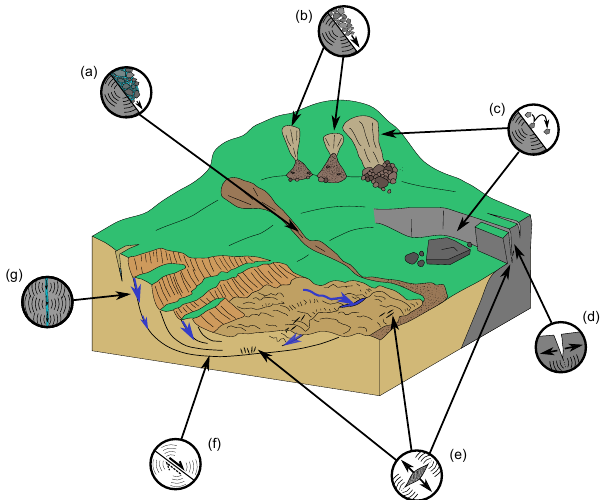
Figure 1. Conceptual scheme of the landslide endogenous seis- mic sources with (a) wet granular flow, (b) dry granular flow, (c) rockfall, (d) tensile fracture opening, (e) tensile cracks opening, (f) shearing and (g) fluid migration in